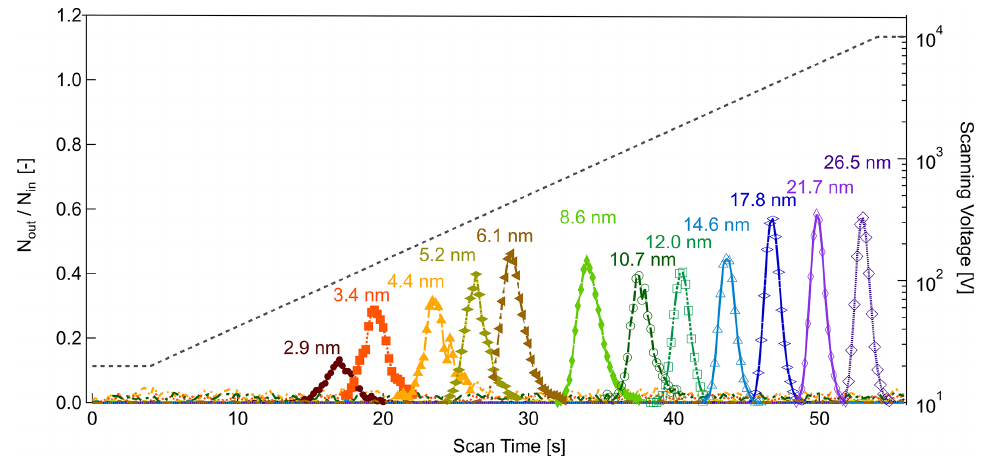
Figure 8. Experimental calibration of the nSEMS using the TDMA setup shown in Fig. 4. Particles entering the nSEMS were classified as described; the reported mobility-equivalent diameters were calculated based on the upstream classifier operating parameters. The nSEMS was operated at the default parameters listed in Table 1, with t ramp = 50s. The ratio of downstream to upstream particle counts of the nSEMS is shown as a function of time over the voltage scan, with input particles in the 2.9–26.5nm range. The applied voltage is indicated by the dashed gray line. Only a fraction of the sizes used in the calibration are shown here for clarity; results from the complete size calibration summary are presented in Fig. 10.